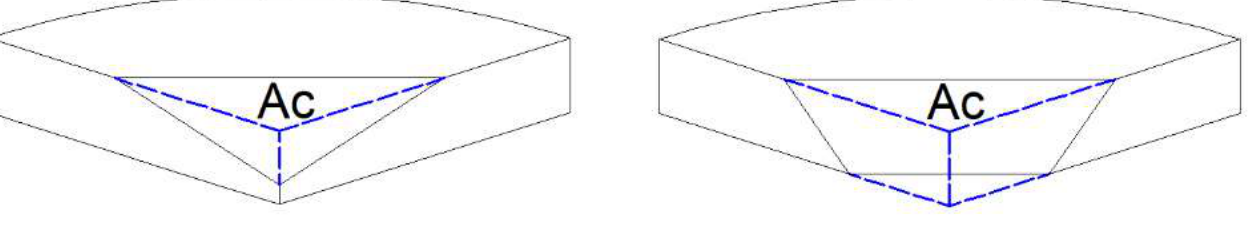
Figure 2. Contact area.